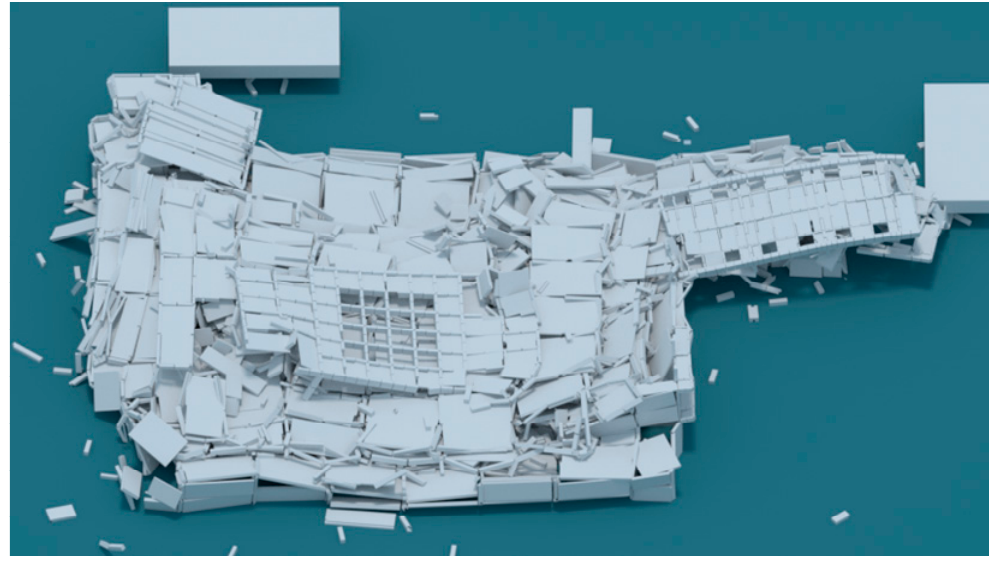
Figure 14. Distribution of the library building ruins.